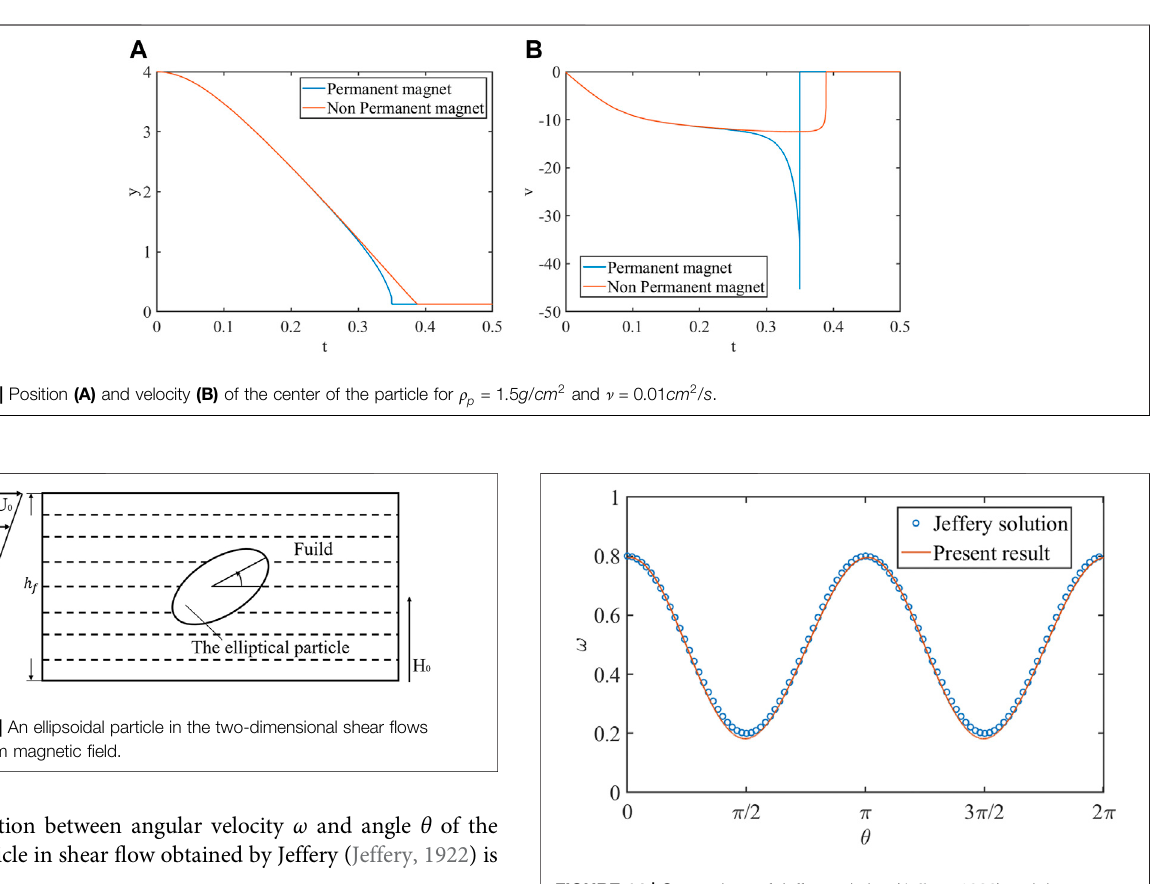
FIGURE 14 | Comparison of Jeffery solution (Jeffery, 1922) and the present simulation